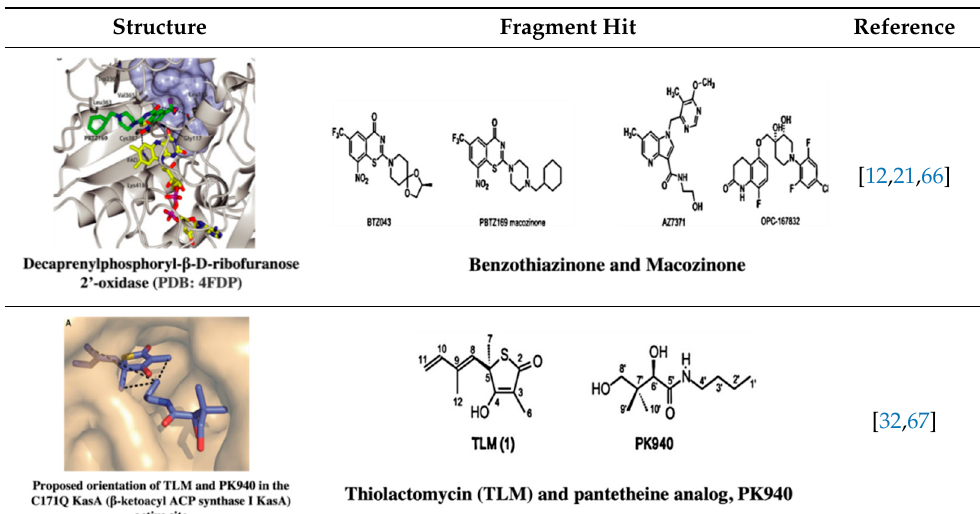
Table 1. TB targets and its fragment hit molecules.